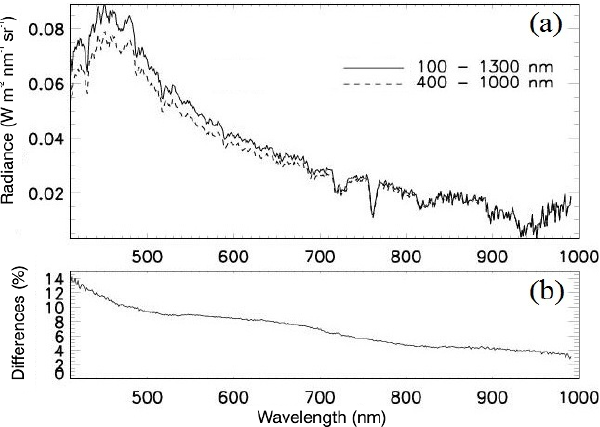
Fig. 5. (a) Spectral radiance measured with AisaEAGLE, for smear Fig. 5: (a) Spectral radiance measured with AisaEAGLE, for smear corrections considering different wavelength intervals in thecalibration,100–1300nm(solidline),400–1000nm(dashedline) (b) Differencesbetweenthespectralradiancesshownin corrections considering different wavelength intervals in the cal- panel (a) . ibration: 100–1300nm (solid line), 400–1000nm (dashed line). (b) Differences between the spectral radiances shown in panel (a)